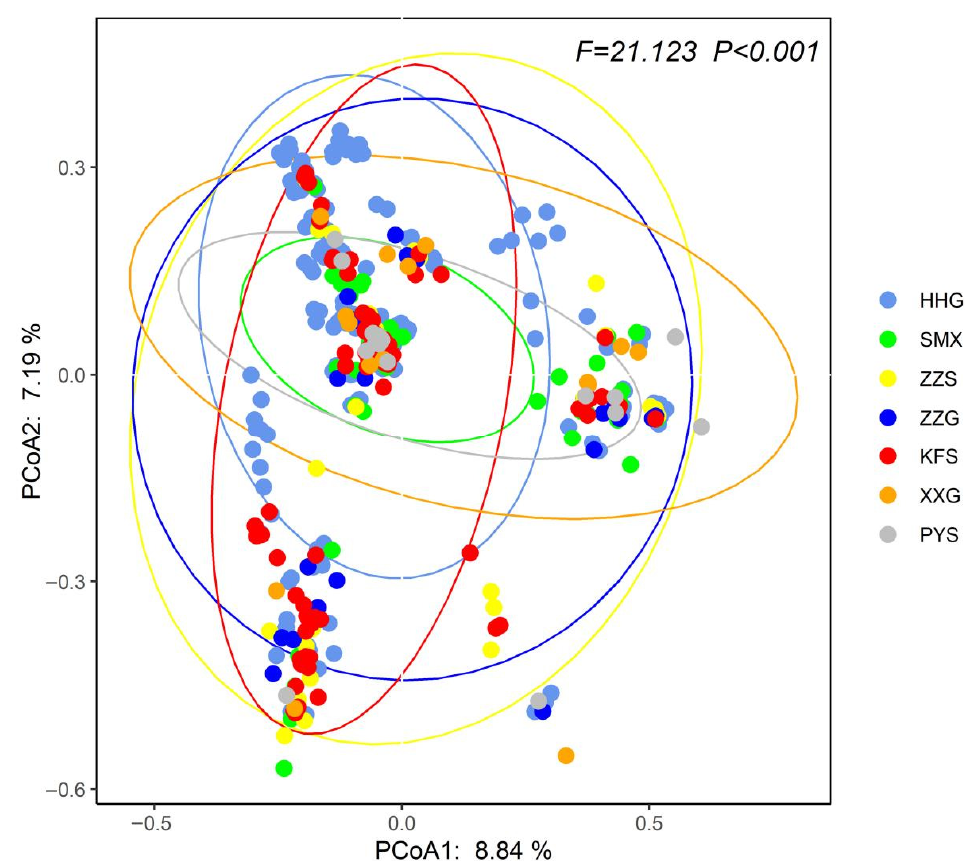
Figure 5. Effect of different nature reserves on the beta diversity of wetland plants determined with the betadisper function. ANOVA is applied to test how these distances differed among different nature reserves. Different colors represent different nature reserves. HHG, Henan Yellow River wetland national nature reserve. SMX, Sanmenxia reservoir area wetland. ZZS, Henan Zhengzhou Yellow River wetland provincial nature reserve. ZZG, Henan Zhengzhou Yellow River national wetland park. KFS, Henan Kaifeng Liuyuankou wetland provincial nature reserve. XXN, Henan Xinxiang Yellow River wetland birds national nature reserve. PYS, Henan Puyang Yellow River wetland provincial nature reserve.